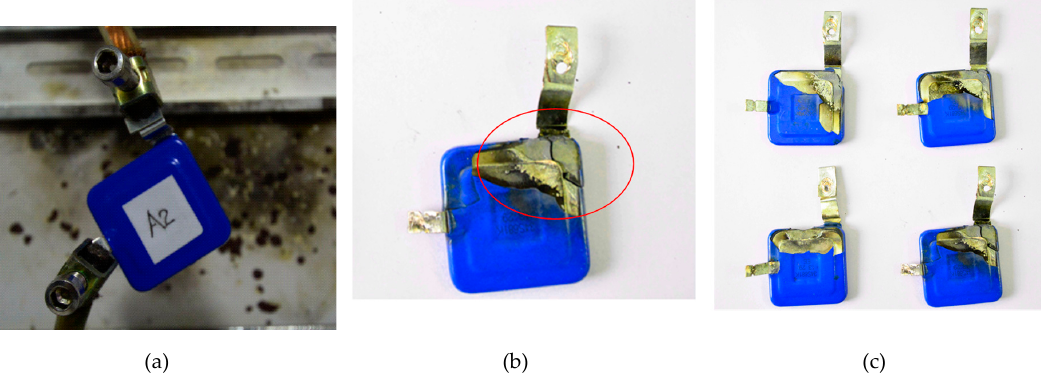
Figure 7. The appearance state diagram of the ZnO varistors before and after the multiple lightning impulse currents. ( a ) The state diagram of Sample A2 before impulses; ( b ) Damage state diagram of Sample A2; ( c ) Damage diagrams of Samples A1 to A4.